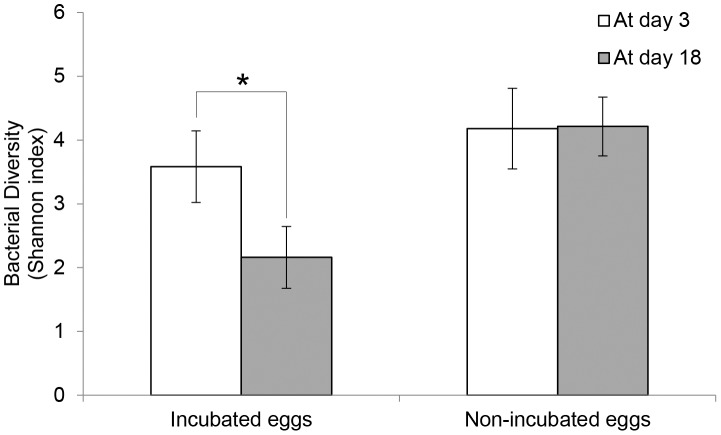
Bacterial diversity (Shannon index; mean) of incubated and non-incubated eggs.Bacterial diversity was estimated by Shannon index with 570 sequences per sample acquired from 16S rRNA gene pyrosequencing, at day 3 and day 18 after egg laying in 9 incubated nests and 3 control nests. Asterisks represent significant difference (P<0.05) by paired t-test between at day 3 and day 18. Error bars denote standard errors.